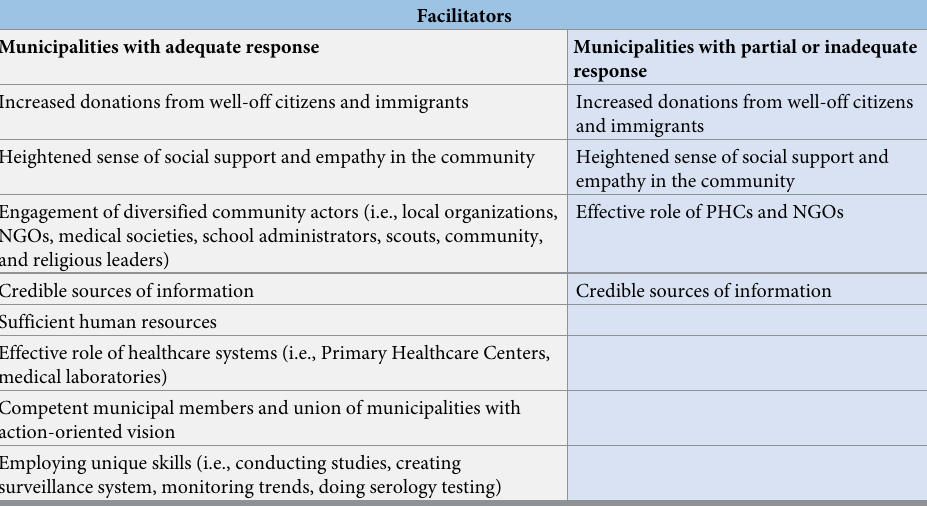
Table 3. Enabling factors for municipalities during the